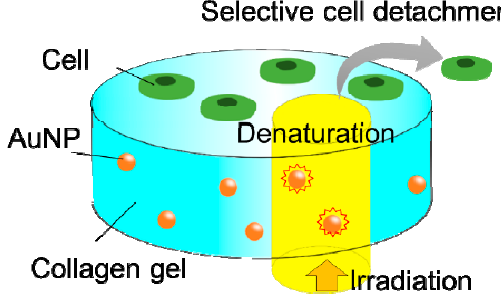
Figure 1. Schematic illustration of photoinduced cell detachment.